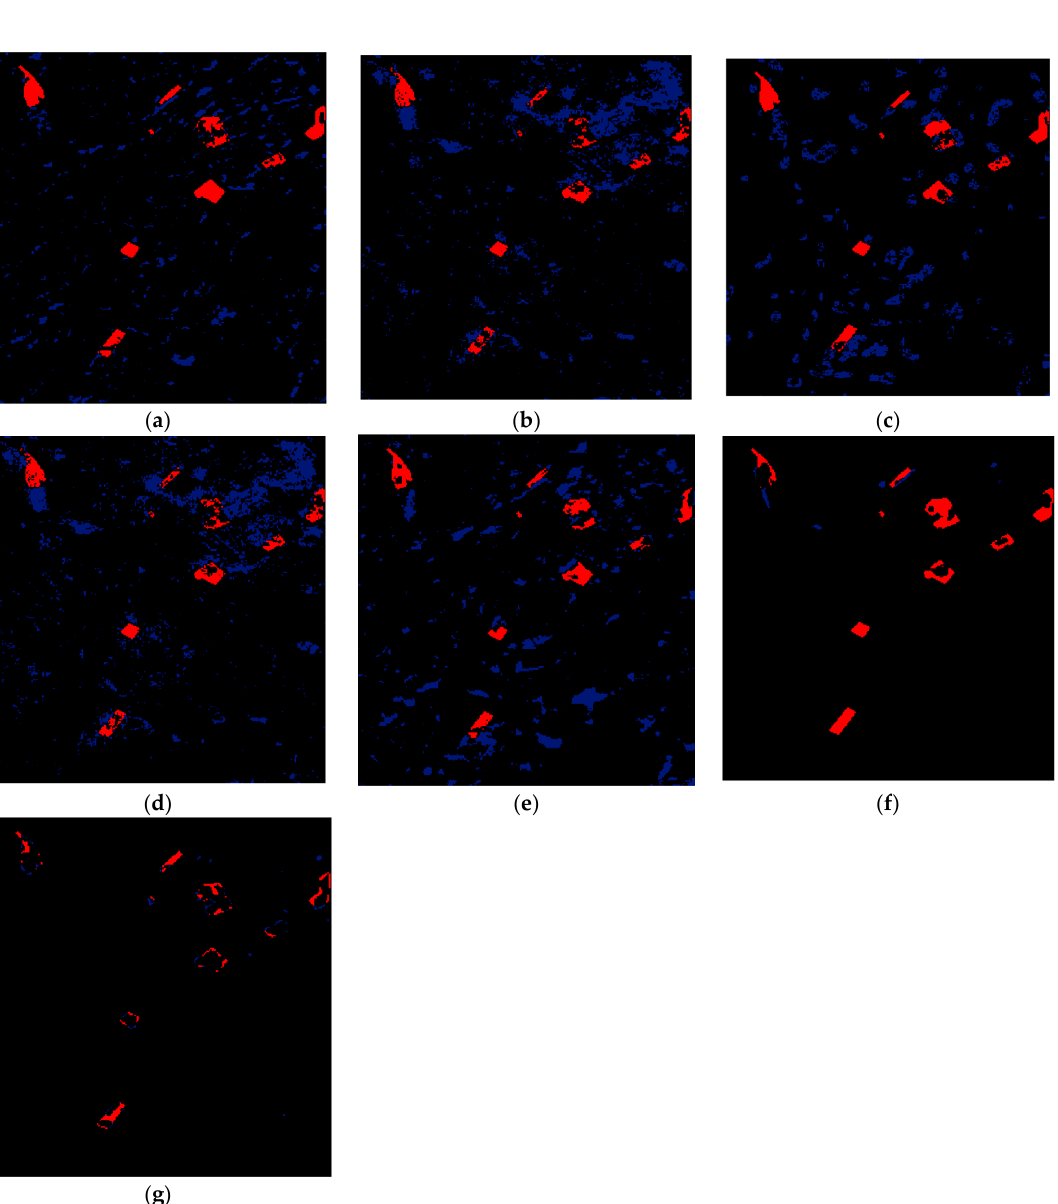
Figure 13. The change detection errors of different methods for the Multispectral-Saclay dataset. ( a ) CVA-SVM, ( b ) MAD-SVM, ( c ) PCA-SVM, ( d ) IR-MAD -SVM, ( e ) SFA-SVM, ( f ) 3D-CNN, and ( g ) Proposed Method. Black, red, and blue colors indicate TP and TN, FN, and FP pixels, respectively.